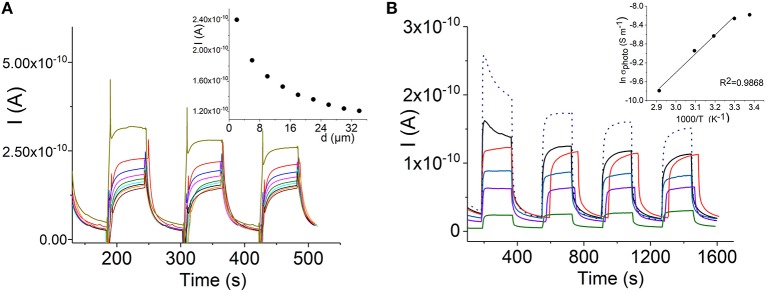
Dependence of the photocurrent of the H4TPPS42--Sn(IV)TPyP4+ porphyrin nanotubes on the path length, interdigitated electrode array (see experimental section), Vapp = 0.5 V (A). Temperature dependence of the photocurrent of the H4TPPS42- - Sn(IV)TPyP4+ nanotubes: 23°C–black line, 30°C– red line, 40°C–blue line, 50°C– violet line,70°C– green line, after cooling down to 23°C–dotted line. Insert shows a dependence of lnσphoto on 1,000/T, 400 nm electrode gap, Vapp = 0.5 V (B).